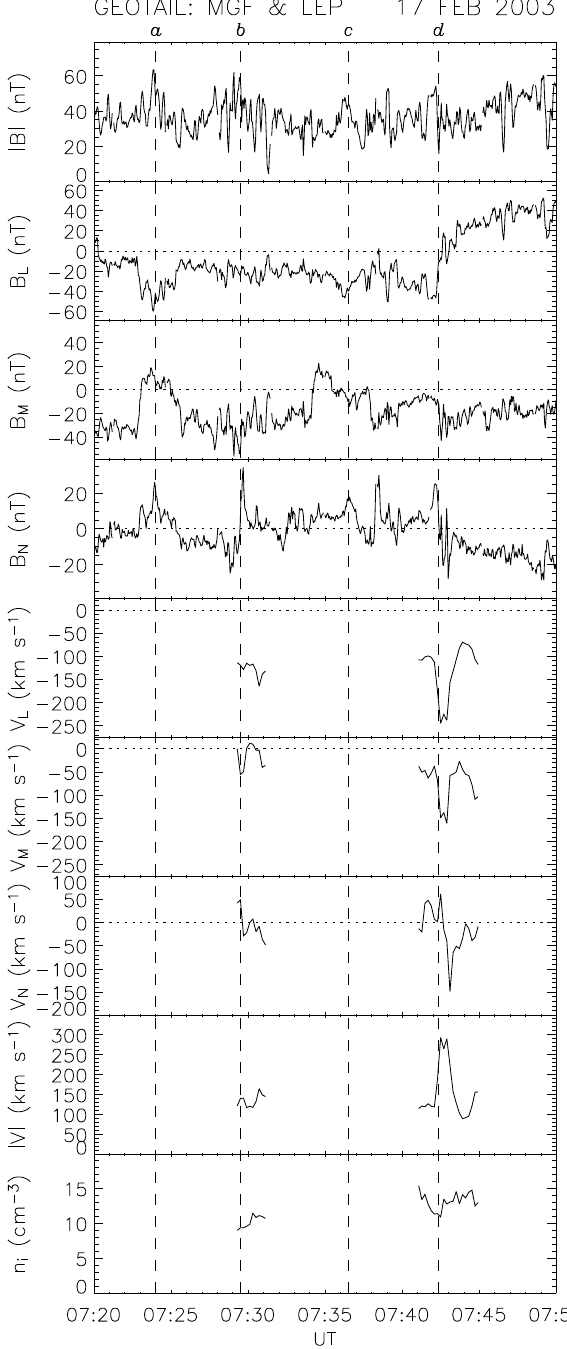
Fig. 5. Magnetic field and plasma observations from the Geotail spacecraft during the interval 07:20–07:50 UT on 17 February 2003 presented in the same format as Fig.